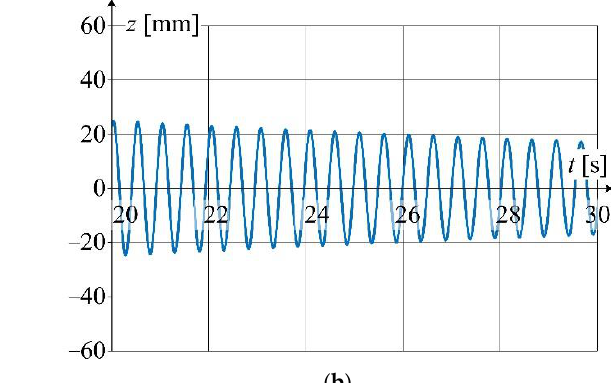
Figure 19. Displacement waveforms of simulation results at non-linear damping coefficient.